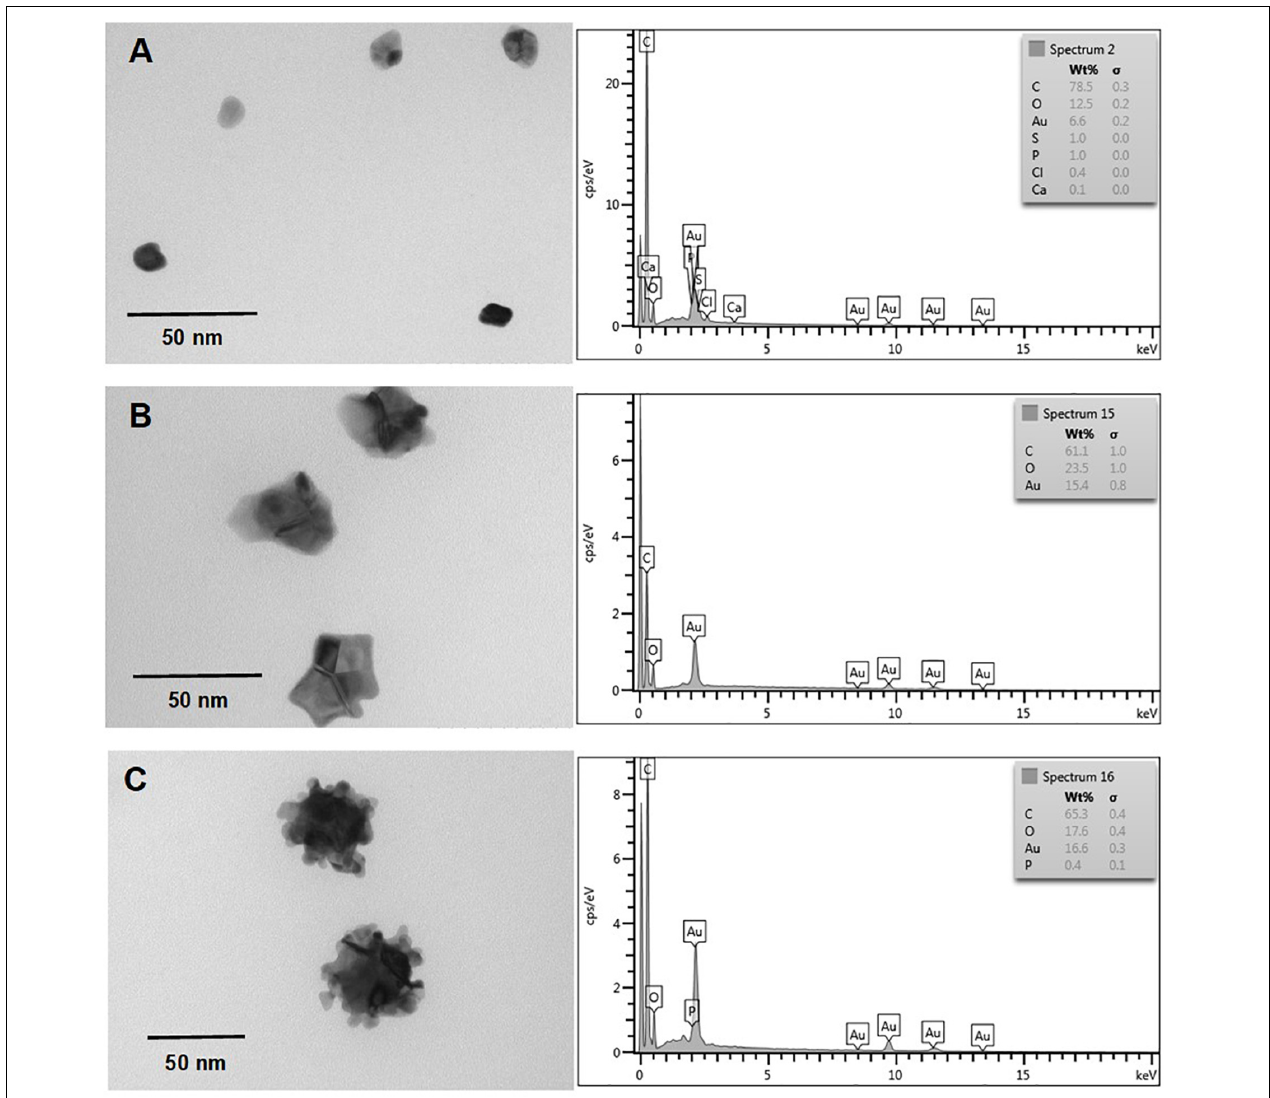
FIGURE 5 | In vitro , aerobic synthesis of AuNS by E. cloacae MF01 crude extracts. Electron micrographs (left) and EDS analysis (right) show AuNS synthesized under the following experimental conditions: (A) NADH/pH 9.0; (B) NADPH/pH 8.0; (C) NADPH/pH